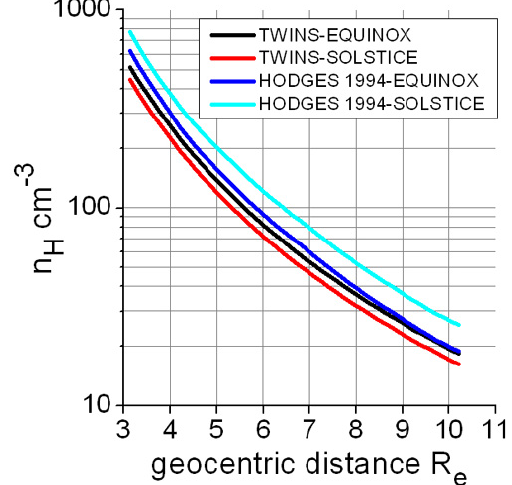
Fig. 13. Radial profiles of TWINS equinox model (black) and the equinox (Hodges, 1994) model (blue) are in good agreement. Dis- crepancies of the the radial profiles of TWINS solstice model (red) and the solstice (Hodges, 1994) model (cyan) are